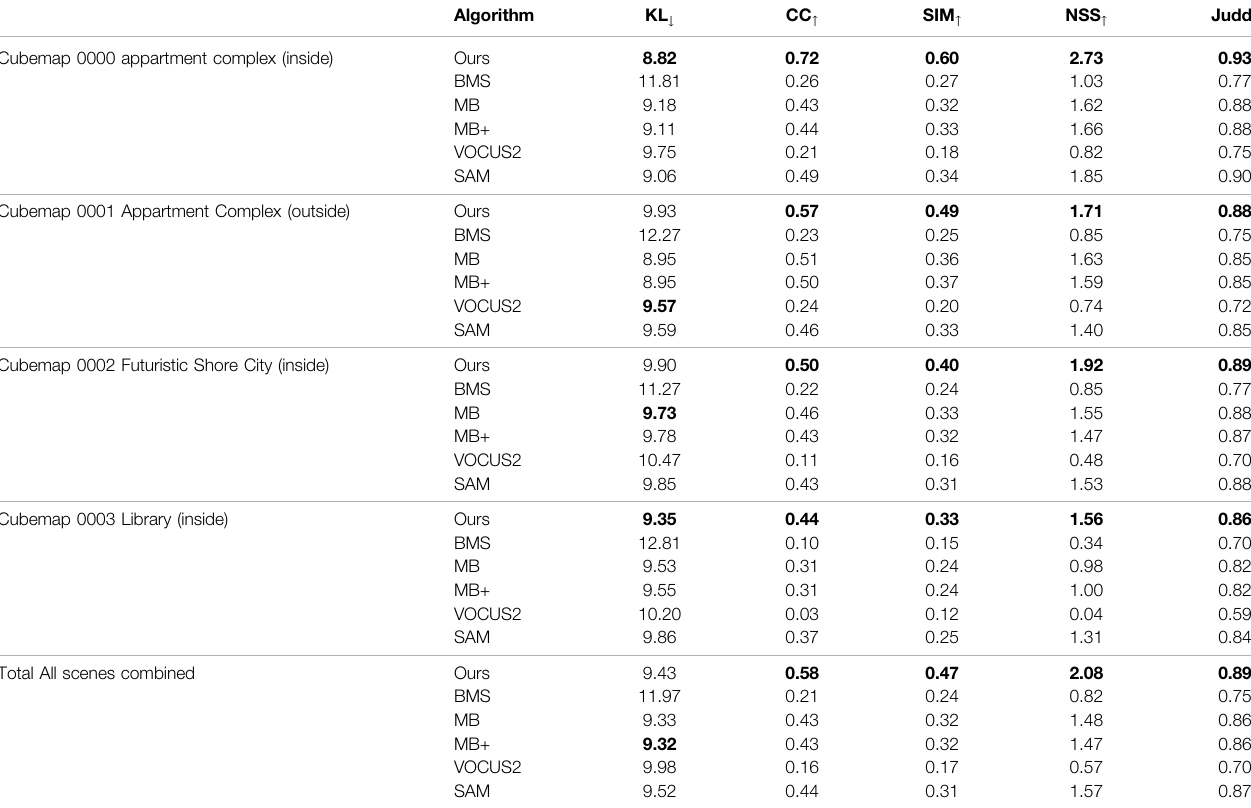
TABLE 2 | Prediction capability of the gaze of the current user on the Saliency in VR dataset (Sitzmann et al., 2018) with our gaze mapping approach (Ours).